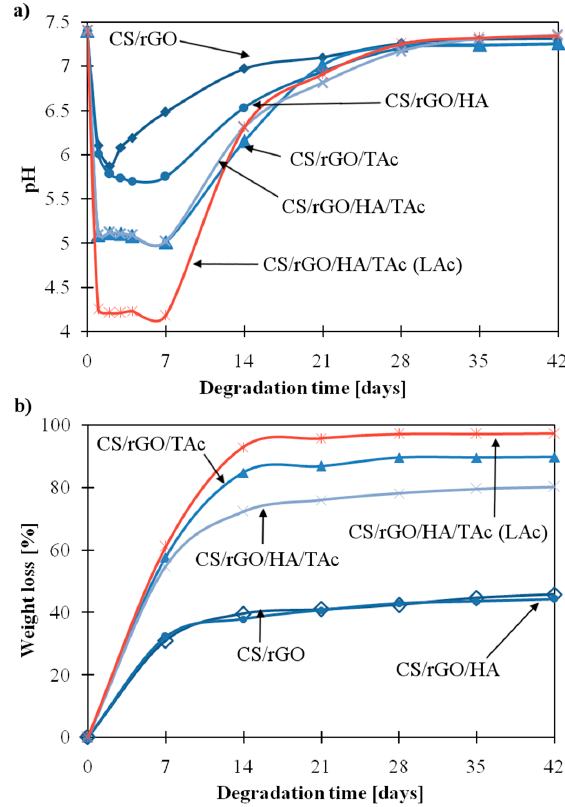
Figure 4. Degradation behavior of CS nanocomposites in PBS (Phosphate Buffered Saline) solution: ( a ) Changes of pH value of degradation media, ( b ) weight loss of samples during incubation, at 37 ◦ C. Blue curves—composites prepared in AAc (acetic acid), red curve—composite prepared in LAc (lactic acid); (CS—chitosan, rGO—reduced graphene oxide, HA—hydroxyapatite, TAc—tannic acid). Materials 2019 , 12 , x FOR PEER REVIEW